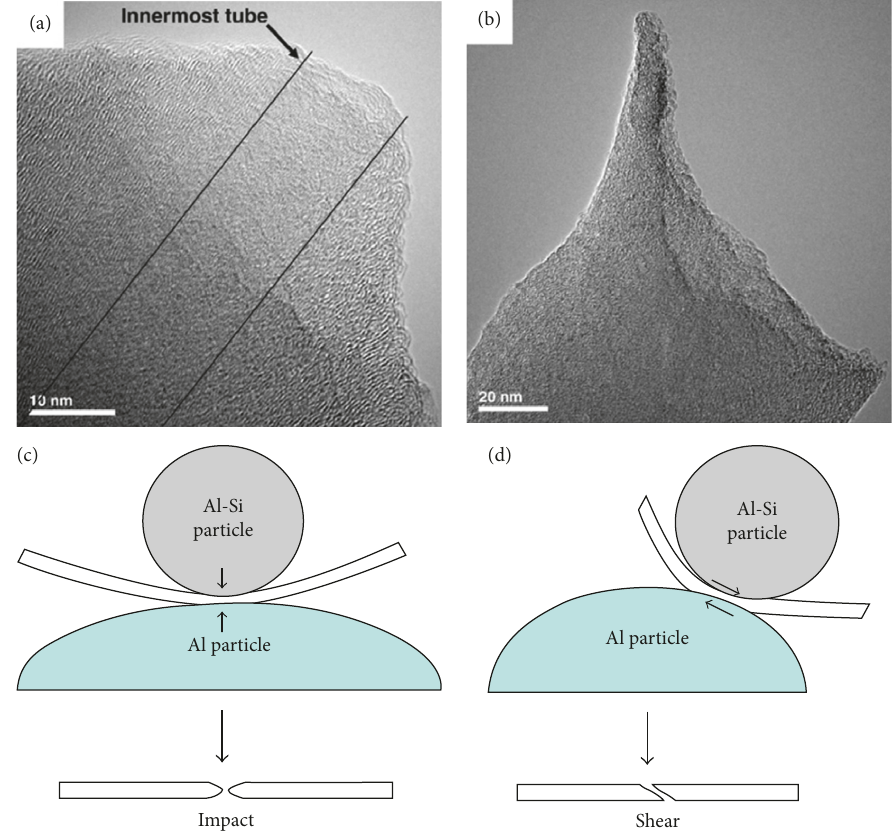
Figure 10: TEM imaging of damaged CNT in the cold-sprayed CNT-Cu coatings and their damaging mechanism: (a, c) impact-induced damage and (b, d) shear-induced damage [44].